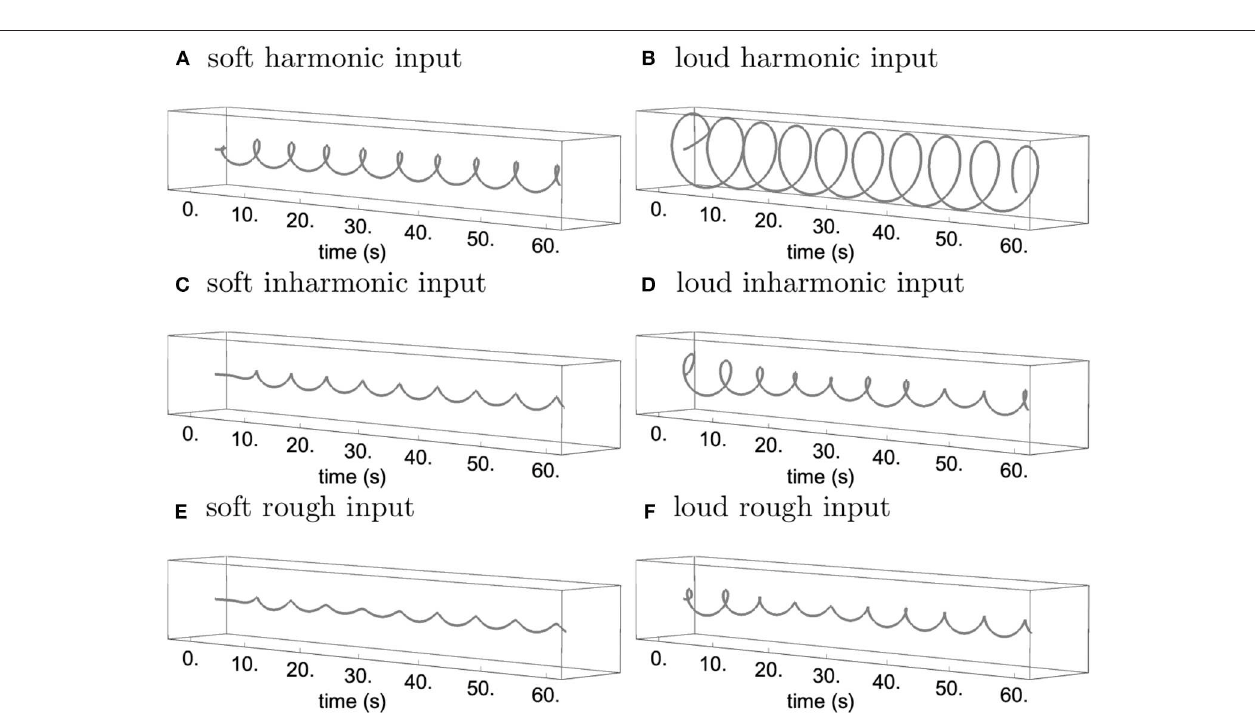
FIGURE 5 | Trajectory of the C 1 oscillator with soft/low-amplitude input corresponding to Figure 1 (A,C,E) and loud/high-amplitude input corresponding to Figure 2 (B,D,F) for the harmonic (A,B) , inharmonic (C,D) , and rough input (E,F) , rendered in the complex plane.